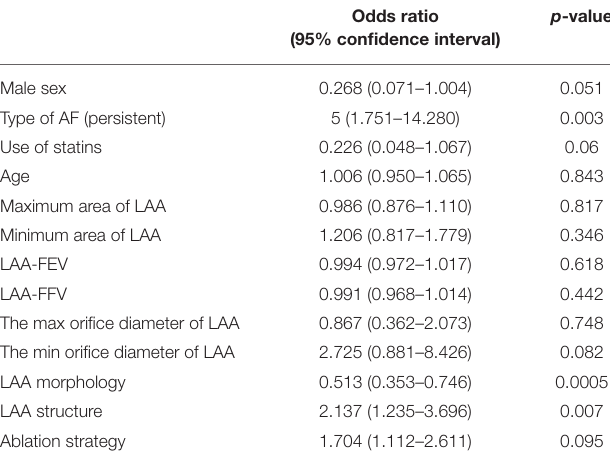
TABLE 8 | Logistic regression analysis for variables with AF recurrence.